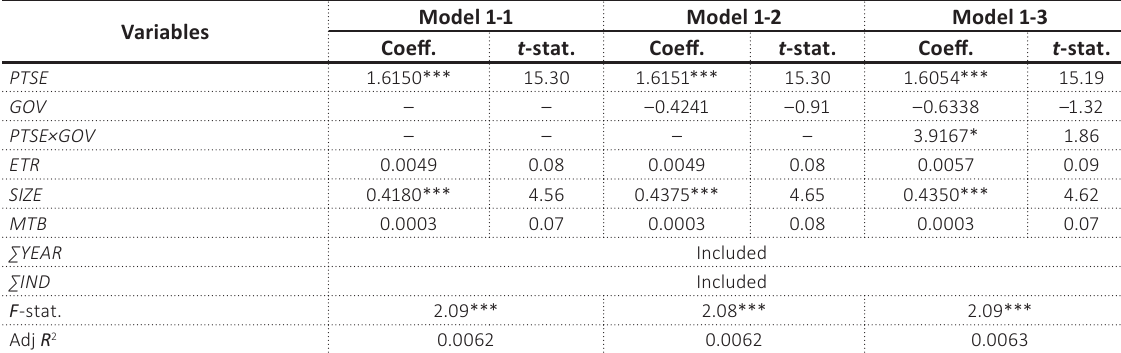
Table 4. Regression results: effects of governmental ownership on the realization of an implicit tax